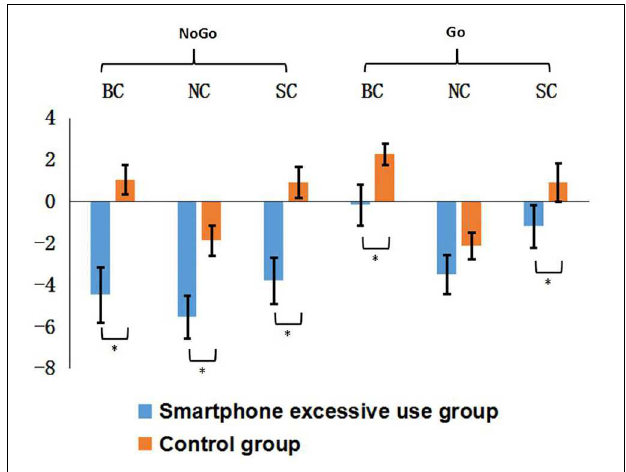
FIGURE 5 | Mean amplitude of N2 for smartphone excessive group and control group in different context. Error bars represent standard error (SE). N2 amplitude recorded in Fz and Fcz channels. ∗ Significant difference refers to a p <